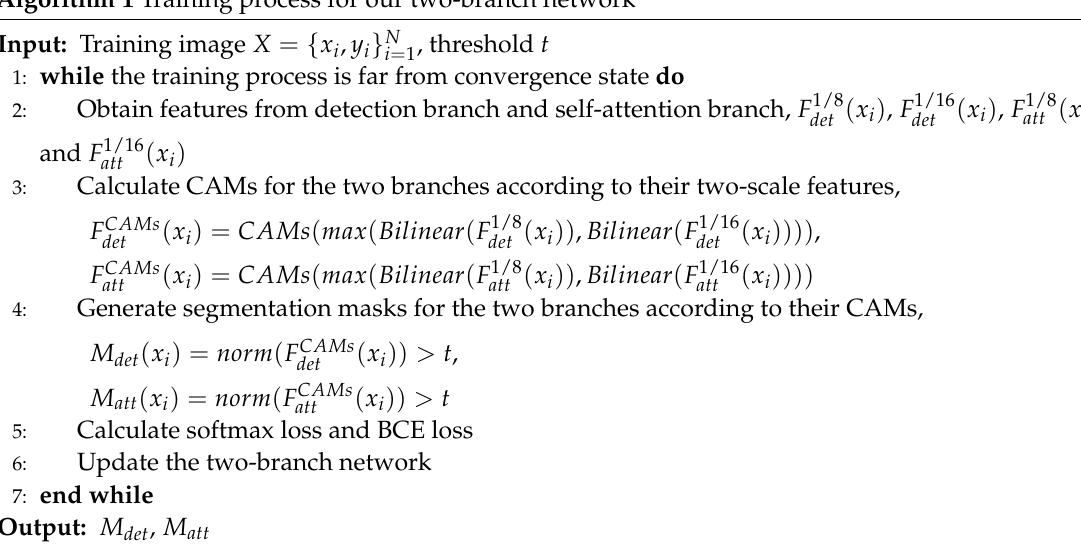
Algorithm 1 Training process for our two-branch